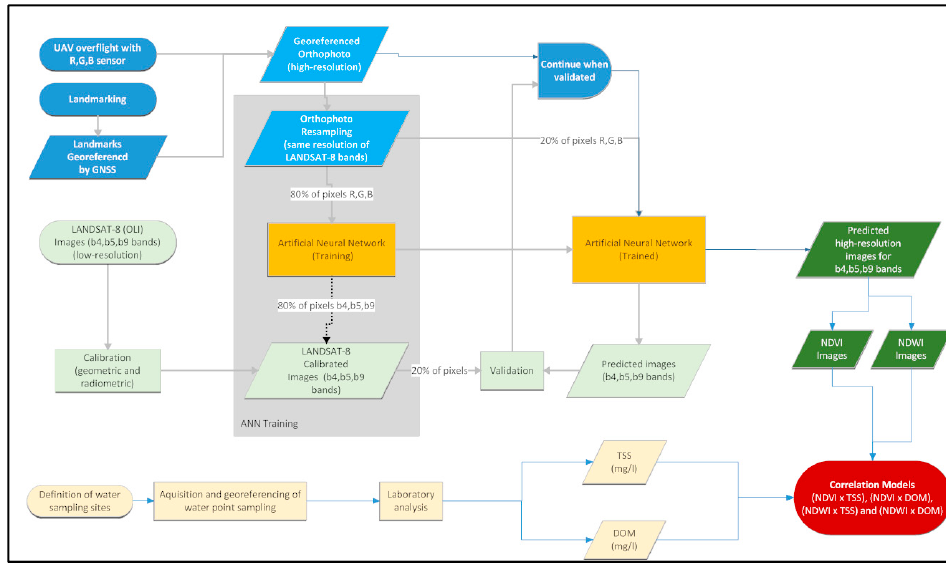
Figure 1. Flowchart of the proposed method.